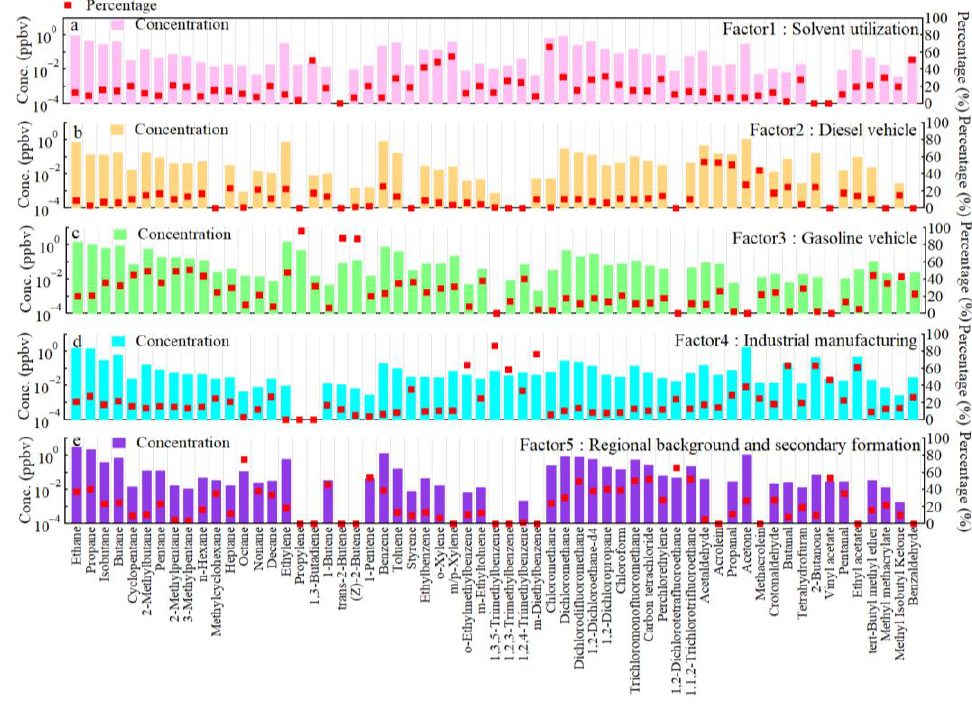
Figure 9. Source profiles of VOCs resolved from PMF in winter.